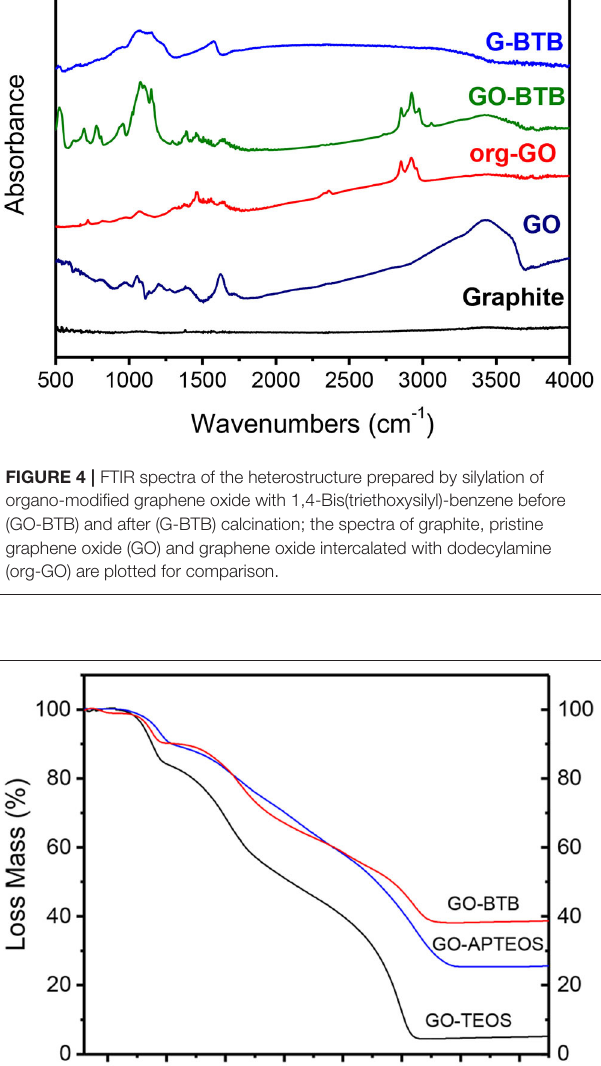
APTEOS, and G-TEOS.